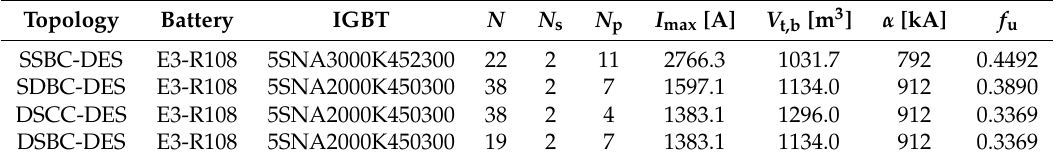
Table 4. Summary of the selected designs for DES topologies.